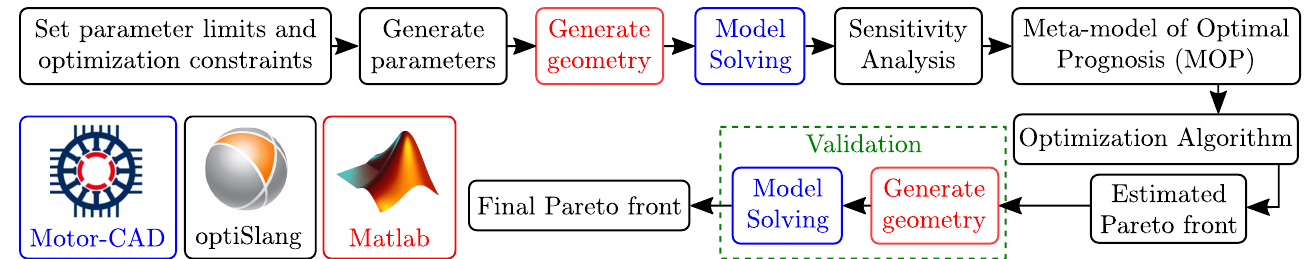
Figure 9. Optimization workflow with Matlab scripting and Motor-CAD FEA tool within Optislang